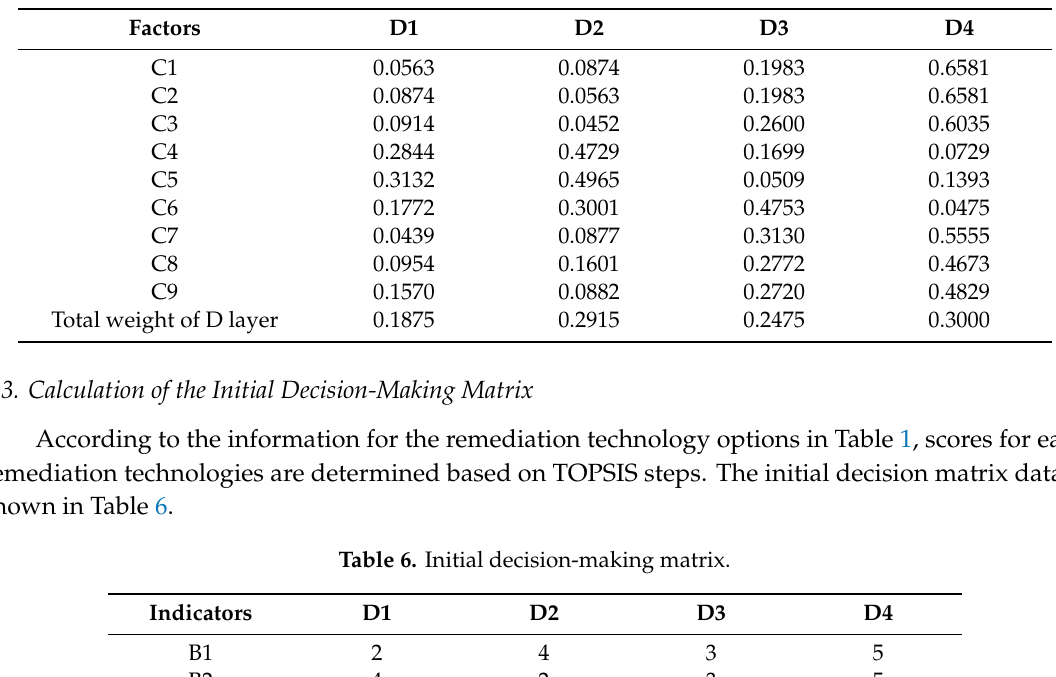
Table 5. Calculation of weight coe ffi cients of the D layer.